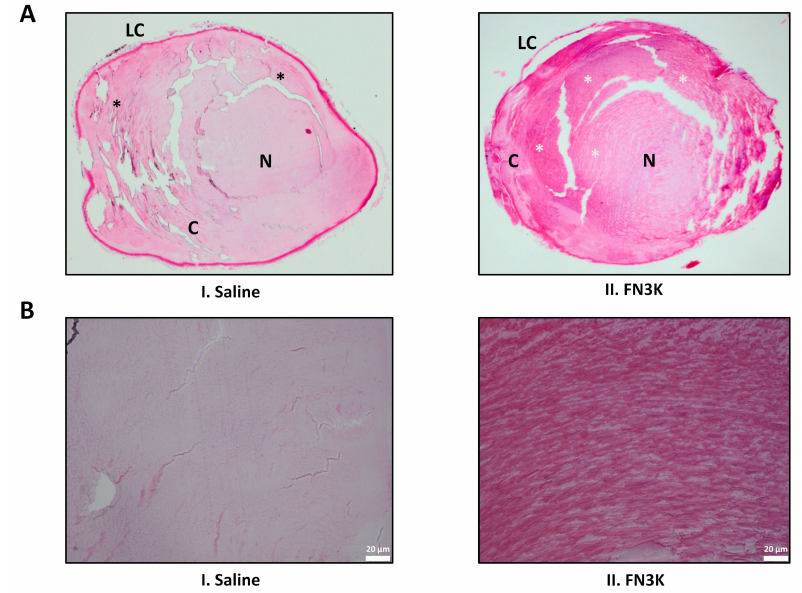
Figure 6. ( A ) Hematoxylin and eosin-stained sections of a saline (I) and FN3K treated (II) lens originating from the same ob/ob mouse. Disorganized and organized zones of lens fibers are indicated with black and white asterisks, respectively. C, cortex; LC, lens capsule; N, nucleus. ( B ) Close-up on the cortical lens fibers of the saline (I) and FN3K treated (II)